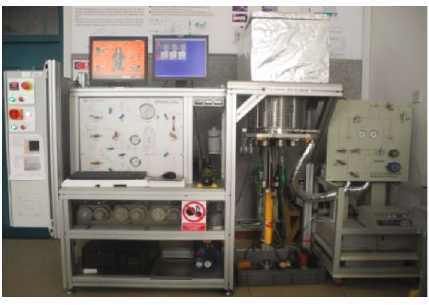
Figure 2: The multiphysics coupling test